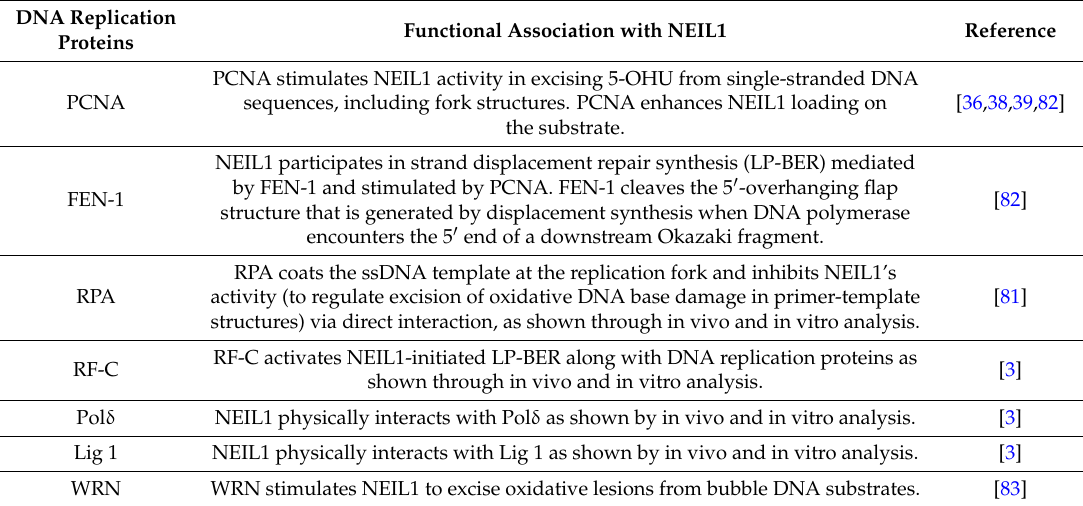
Table 3. Functional association of DNA replication proteins with NEIL1. DNA Replication